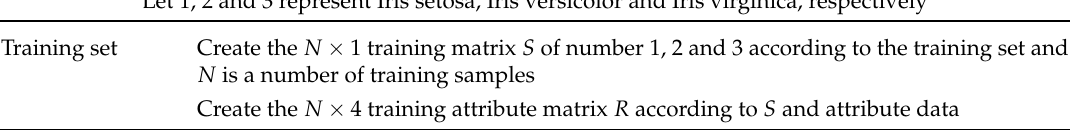
Table 8. Details about the classification of Iris dataset experiment.